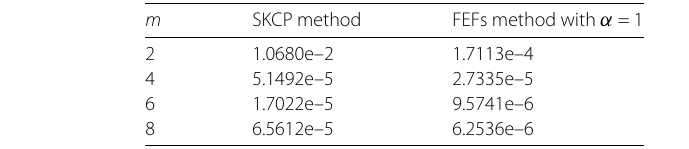
Table 4 The root-mean-square errors ξ m of the FEFs method and the SKCP method for Example 3